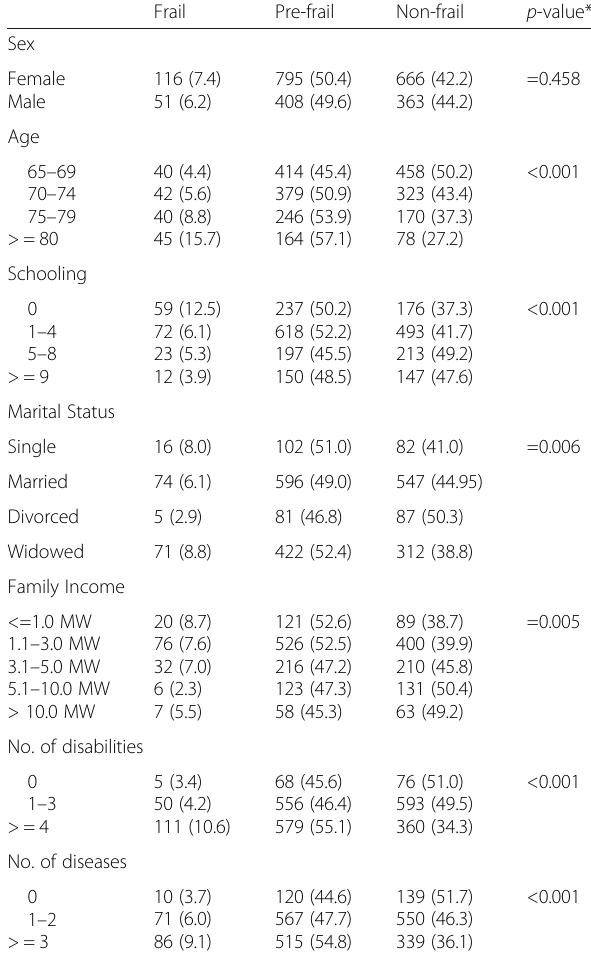
Table 3 Comparison among sociodemographic characteristics and frailty profiles ( n = 2399). FIBRA Unicamp, Elderly, 2008 –